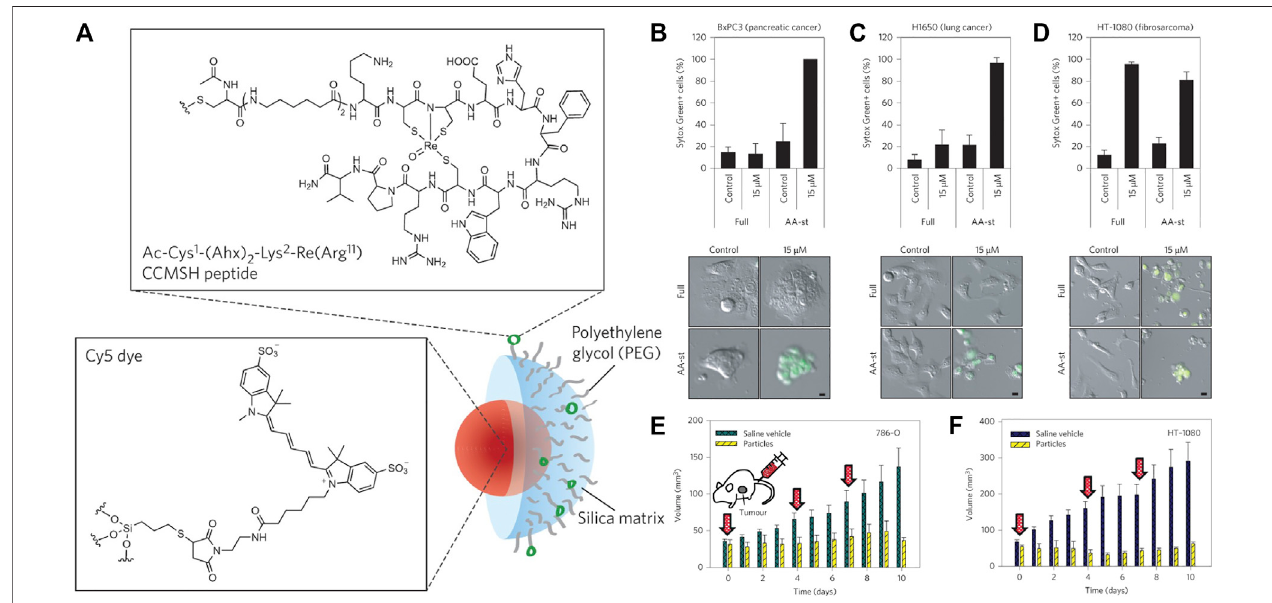
FIGURE 3 | (A) Synthesis scheme of α MSH-PEG-C ′ dots. (B – D) Cell death about BxPC3 cells with different treatments (B) , H1650 cells (C) , and HT-1080 cells (D) . (E) 786-O and (F) HT-1080 tumor volume with different treatments. Reproduced with permission from Kim et al., (2016) Copyright @ 2016 (Springer Nature).